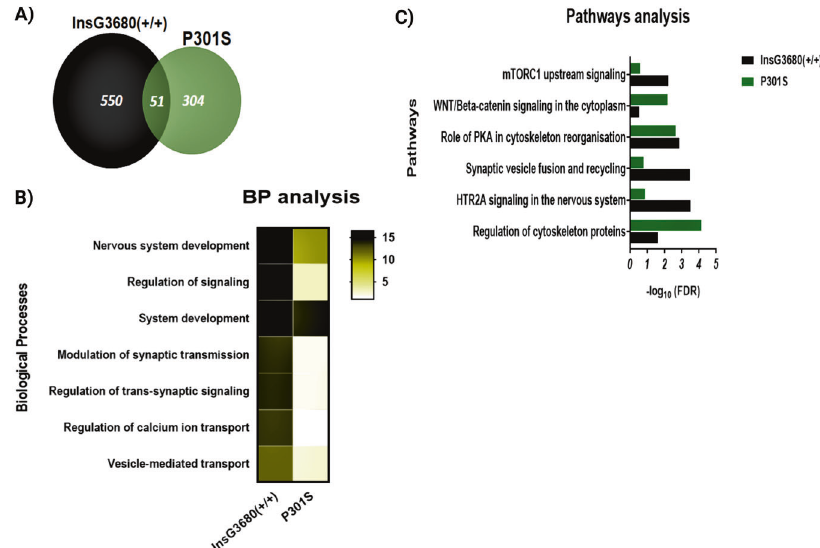
Fig. 2 Systems biology analysis of the SNO proteins of the ASD and AD cortex samples. A Venn diagram of the SNO proteins. B Heat map representing the BP analysis conducted on the SNO proteins exclusive to ASD and AD models. *The scale represents the − log10 of the corrected false discovery rate (FDR). C Pathways analysis of the SNO proteins exclusive to ASD and AD models. *Bars represents the − log10 of the Benjamini corrected false discovery rate (FDR).